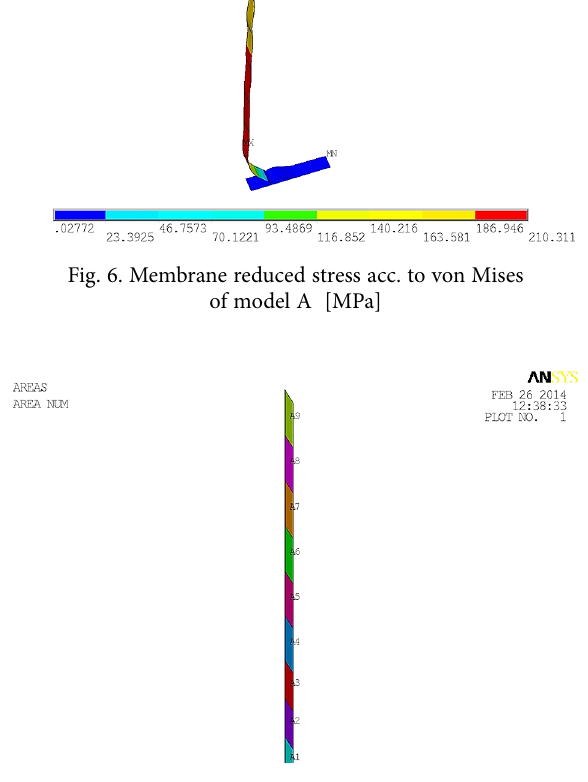
Fig. 5. Total deformation of model A [mm]